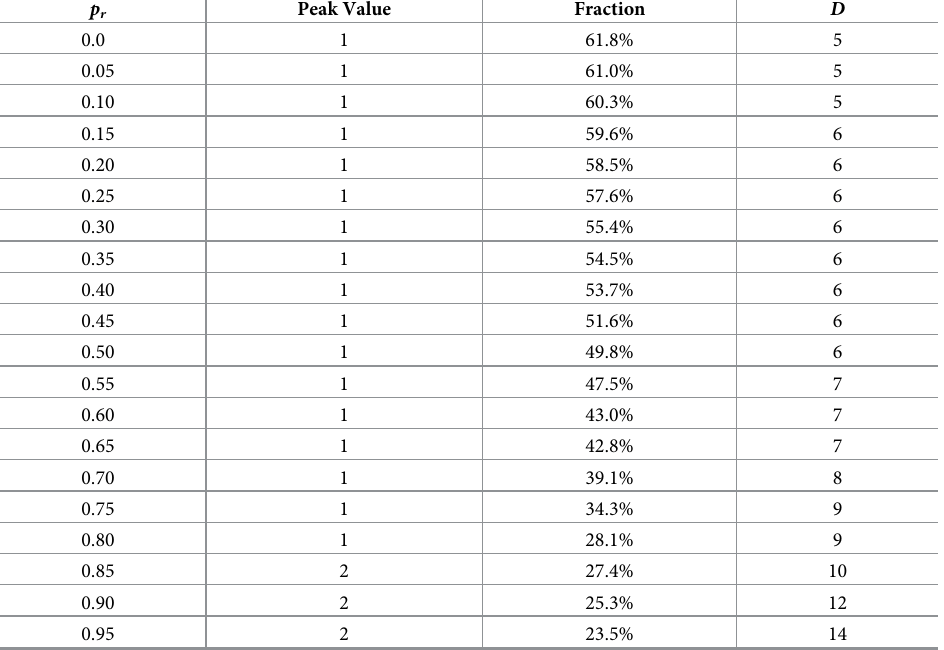
Table 3. Peak value and max value of the path length from a regular bot to a sensor bot under different pr. p r Peak